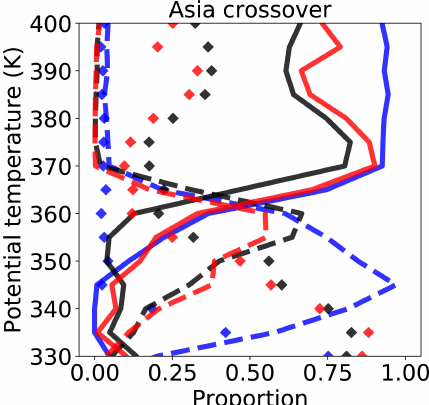
Figure 12. Solid and dashed curves: proportion of forward dia- batic trajectories for which the mean vertical position during life- time is in a 5K bin, respectively above or below that of the origin. Diamonds: proportion of forward trajectories with a mean vertical position within the origin 5K bin. Black: ERA5 in the FullAMA domain. Red: ERA-Interim in the FullAMA domain. Blue: ERA- Interim in global domain. The curves are plotted for the whole Asia